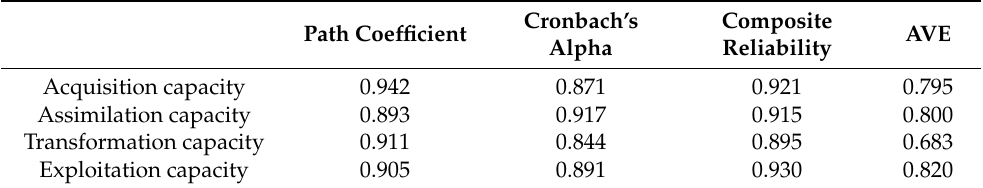
Table 3. Cronbach’s alpha, composite reliability and average variance extracted (AVE) of the first order composites.